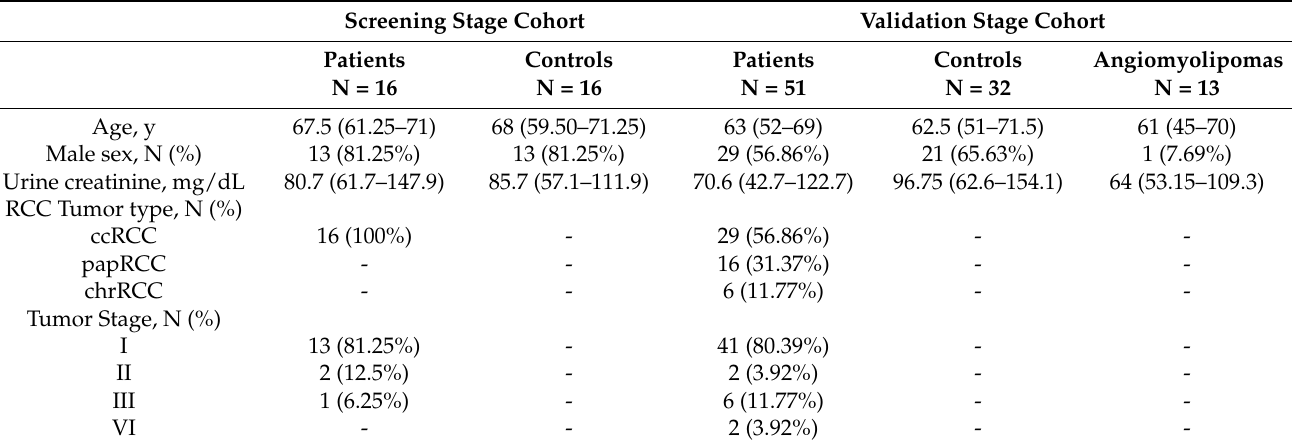
Table 1. Clinical characteristics of the RCC patients and controls